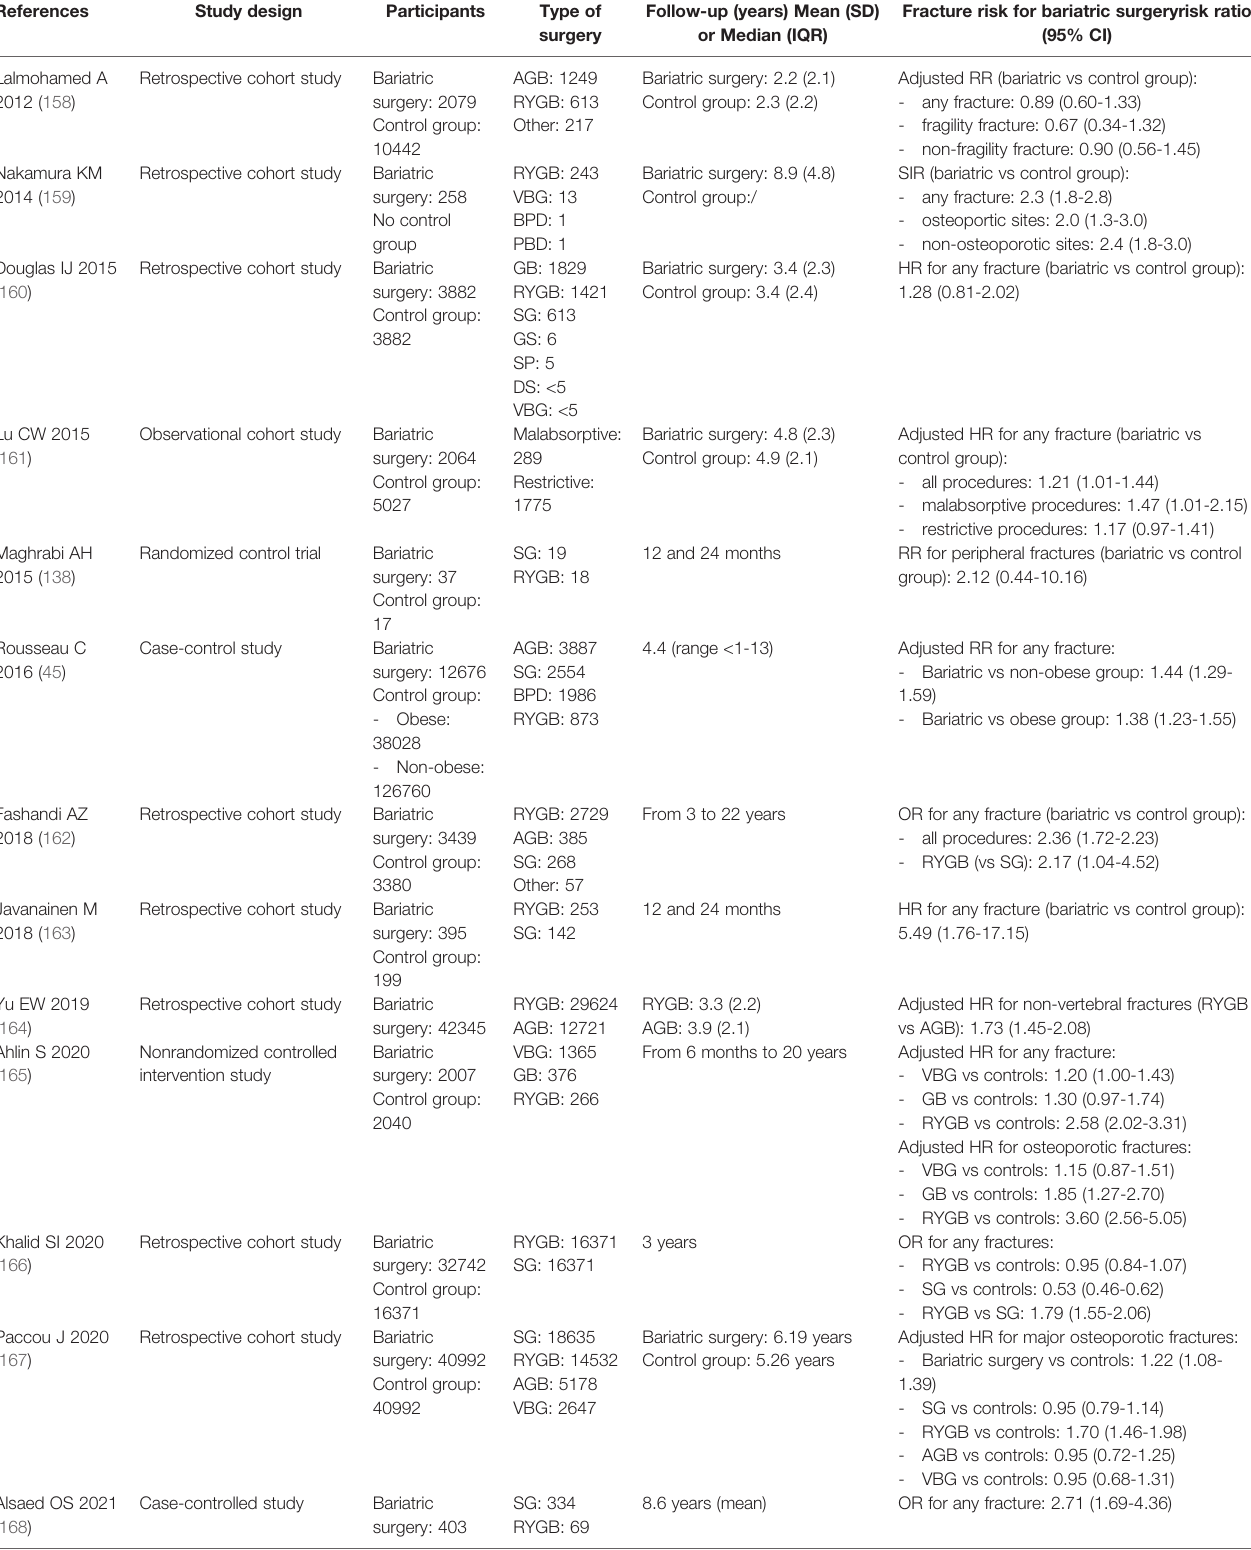
TABLE 2 | Summary of the observational and interventional studies on the fracture risk after bariatric